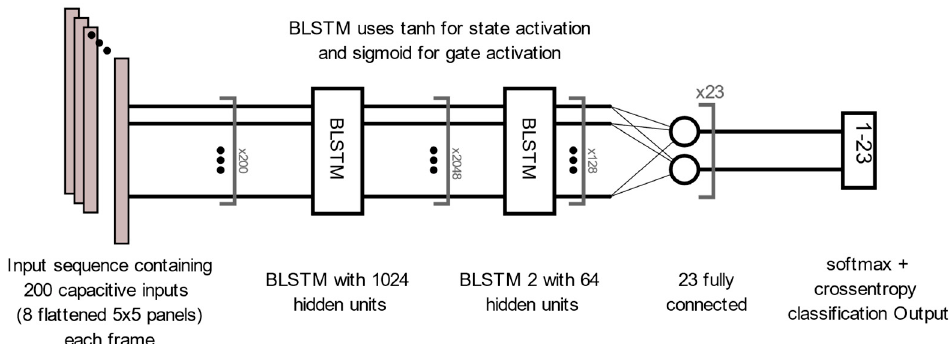
Figure 6. Best Performing Identity Classification Structure: BLSTM.